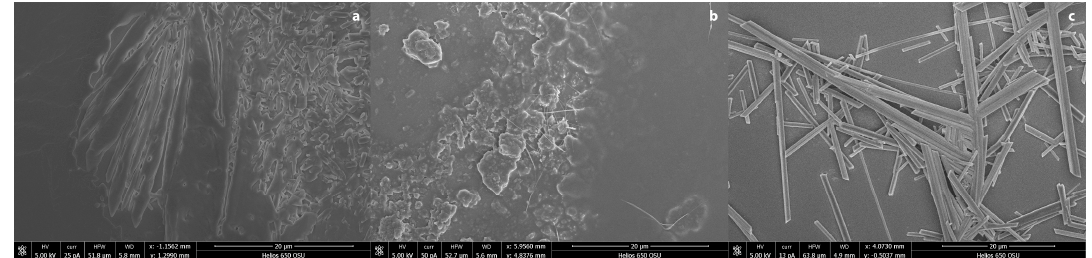
Figure 7. Printed glass with ( a ) CTAB-based ink; ( b ) ethanol-based ink; and ( c ) acetone-based ink. Images taken with a FEI Helios 650.